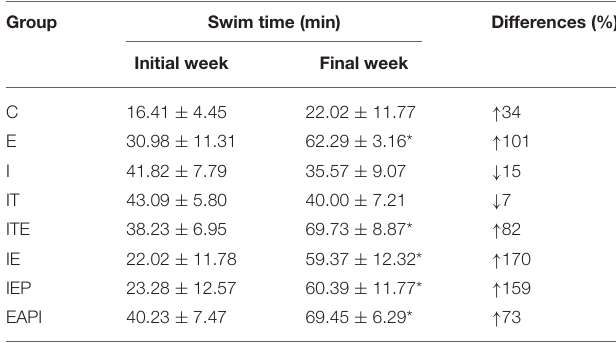
TABLE 1 | Maximal physical capacity of animal groups in a timed swim test at the start and end of the study. Group Swim time (min) Differences (%) Initial